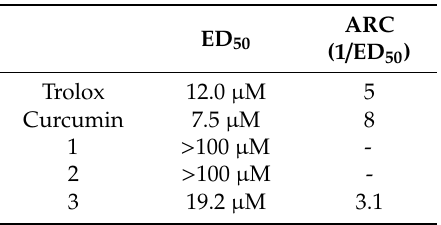
Table 3. DPPH free radical scavenging activity. The results were expressed as the antiradical capacity (ARC), which is the inverse of the ED 50